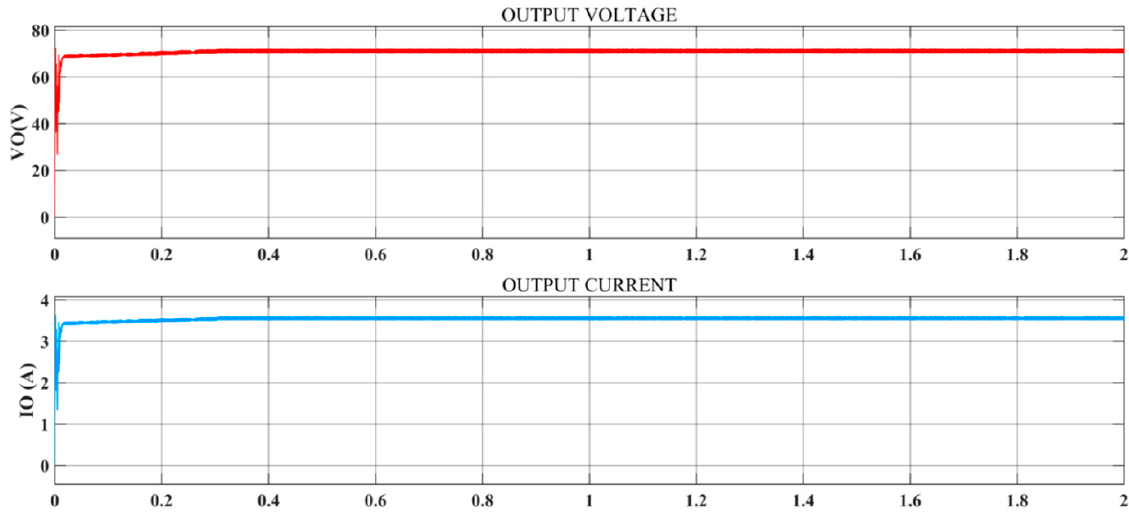
Figure 13. Output voltage and current waveforms of the proposed MPC.